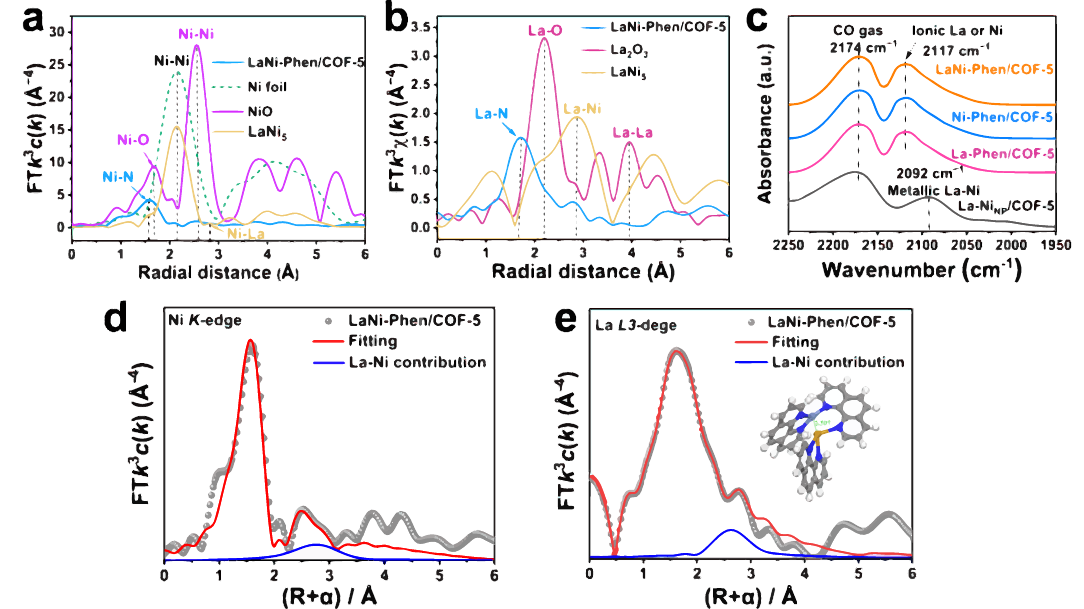
Fig. 3 | Structural characterization by X-ray absorption spectroscopy. a Ni K-edge extended X-ray absorption fi ne structure (R space plots), b La L3-edge extended X-ray absorption fi ne structure (R space plots). c DRIFTS spectra of adsorbed CO on La-Phen/COF-5,Ni-Phen/COF-5,LaNi-Phen/COF-5,and a reference